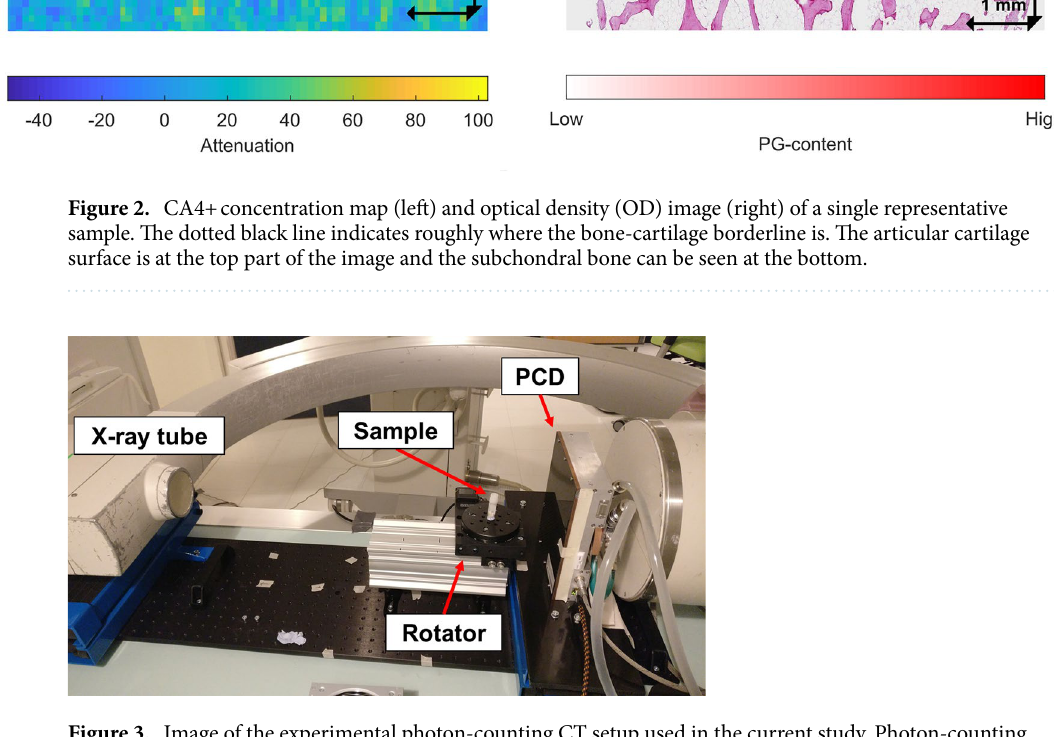
Figure 3. Image of the experimental photon-counting CT setup used in the current study. Photon-counting detector (PCD) is in front of the C-arm’s own detector that is not used in this